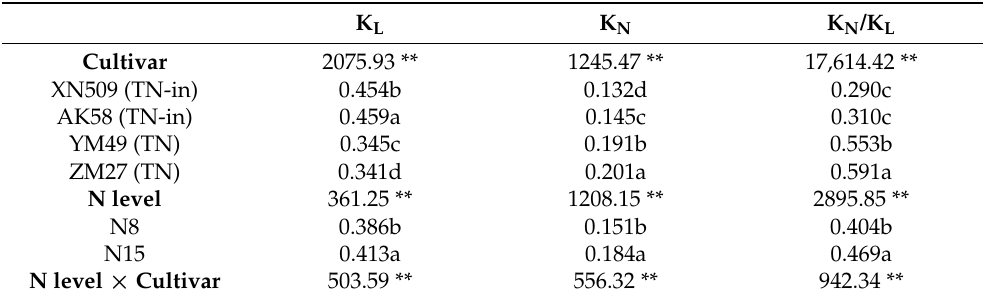
Table 7. K L , K N , and K N /K L of two N-efficient and two N-inefficient winter wheat varieties under different N